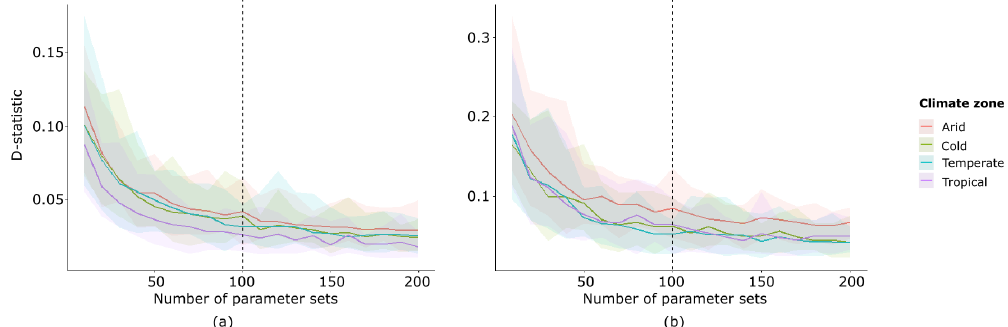
Figure 2. D statistics for maximum (a) and minimum (b) runoff in one model structure (UL1) with 12 parameters, which result from the Kolmogorov–Smirnov test. The other model structures show a similar trend (not shown). The bands are a result of the different parameter samples; the different colours represent the four climate